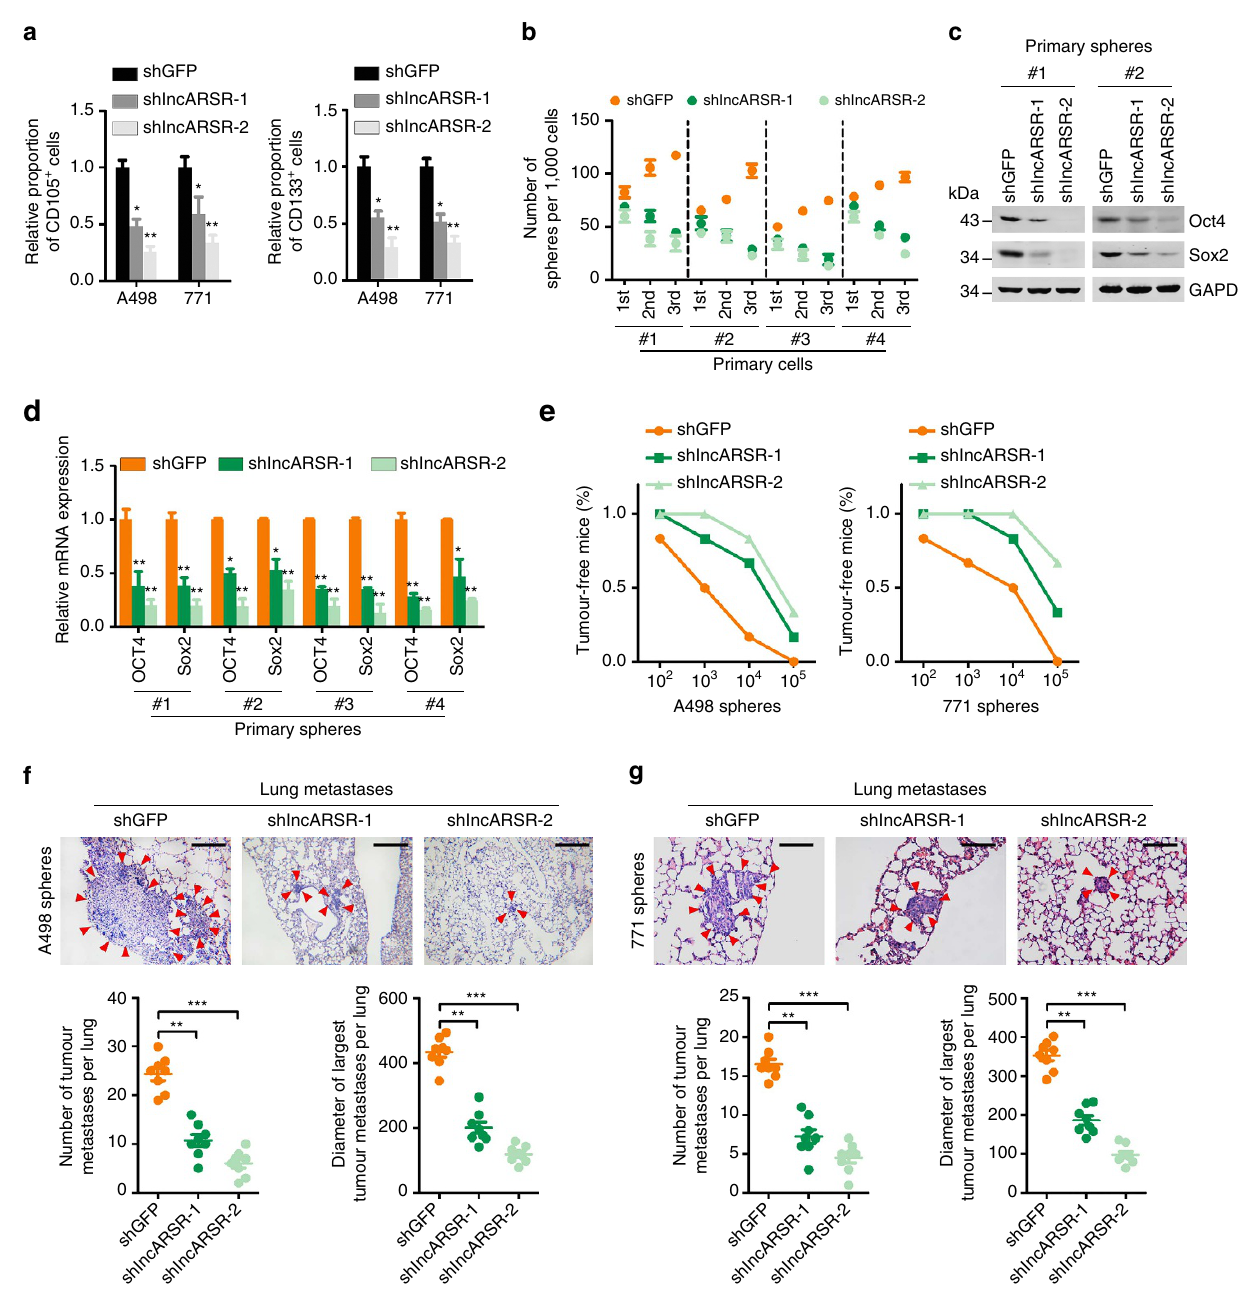
Figure 2 | lncARSR is required for the maintenance of renal T-ICs. ( a ) Flow cytometric analysis of the proportion of CD105 þ (left) or CD133 þ (right) cells in lncARSR-knockdown and control RCC cells ( n ¼ 3). Data are represented as mean ± s.d.; * P o 0.05 and ** P o 0.01; two-tailed Student’s t -test. ( b ) Spheres formation assay of lncARSR-knockdown and control primary ccRCC cells ( n ¼ 3). The number of primary, secondary and tertiary passaged spheres was counted after 7 days. ( c ) Western blot analysis of Oct4 and Sox2 in lncARSR-knockdown and control primary ccRCC spheres. GAPDH acted as a loading control. ( d ) qRT–PCR analysis of indicated mRNAs in lncARSR knockdown and control primary ccRCC spheres. Data are represented as mean ± s.d.; * P o 0.05 and ** P o 0.01; two-tailed Student’s t -test. ( e ) In vivo limiting dilution assay of lncARSR knockdown and control sphere-derived RCC cells. Tumours were observed over 2 months; n ¼ 6 for each group. ( f , g ) Representative microscopic images of pulmonary metastatic lesions at 12 weeks after the injection of indicated sphere-derived RCC cells into the tail vein of nude mice (upper). Red arrows indicate lung metastatic tumours. Scale bar, 200 m m. The number (lower left) and diameter (lower right) of lung metastatic tumours in each group ( n ¼ 8) were calculated. Data are represented as mean ± s.d.; ** P o 0.01 and *** P o 0.001; two-tailed Student’s t